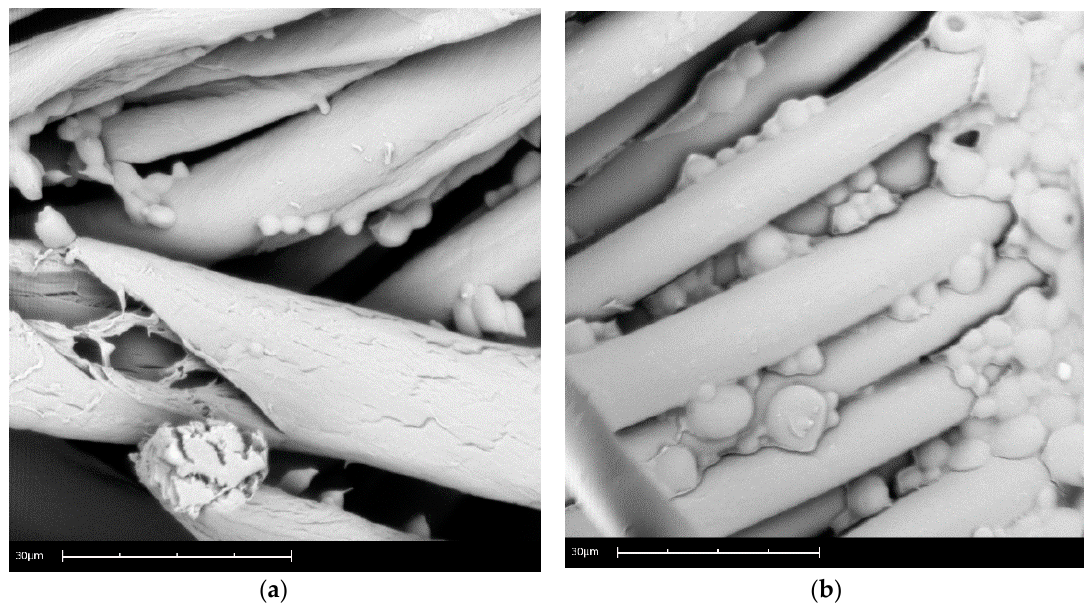
Figure 4. Scanning electron of microcapsules: ( a ) cotton, and ( b ) polyester.